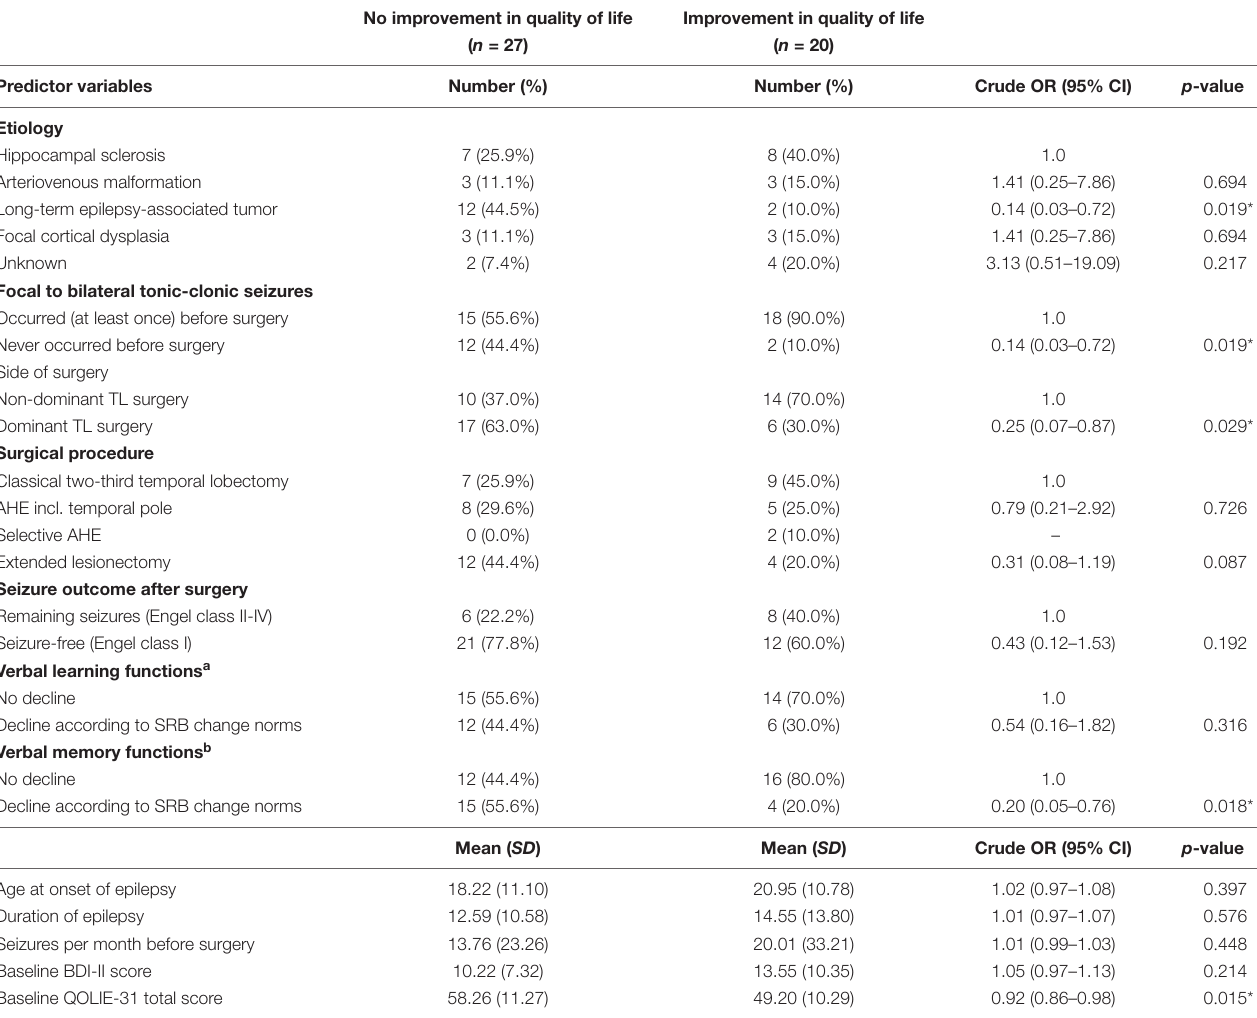
TABLE 6 | Crude odds ratios (OR) and respective 95% confidence intervals (CI) measuring the association between improvement in quality of life (QOLIE-31 total score) and several pre- and postsurgical predictor variables. No improvement in quality of